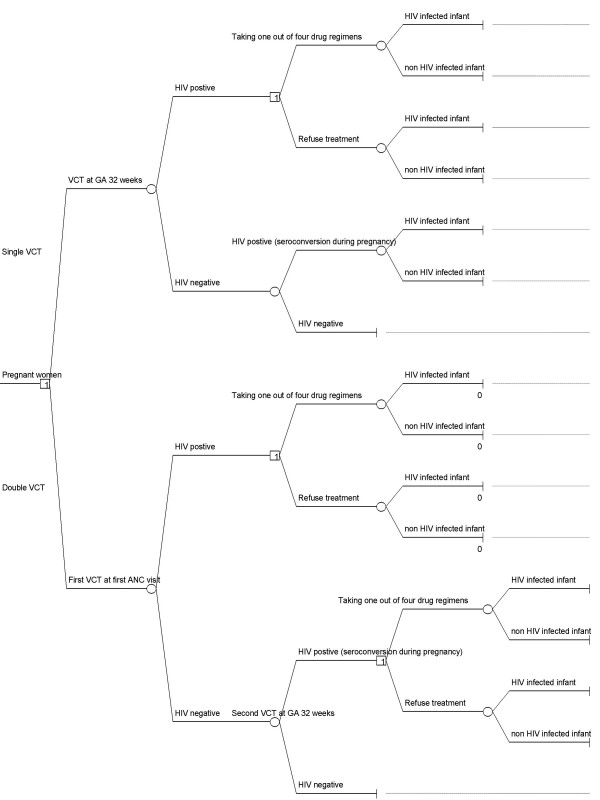
The decision tree used to model the prevention of HIV vertical transmission. (VCT = voluntary counseling and HIV testing, GA = gestational age).